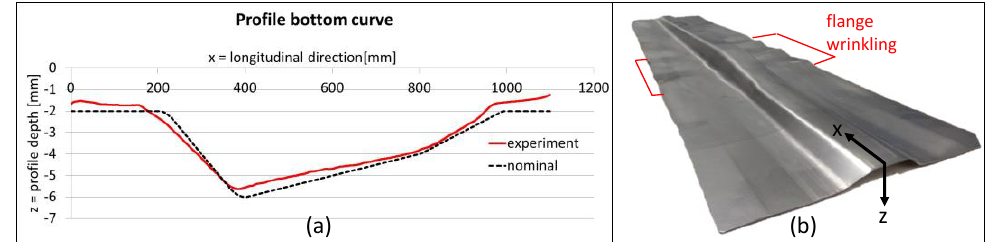
Figure 4. Experimental results: ( a ) manufactured profile bottom curve; ( b ) picture of the manufactured profile.